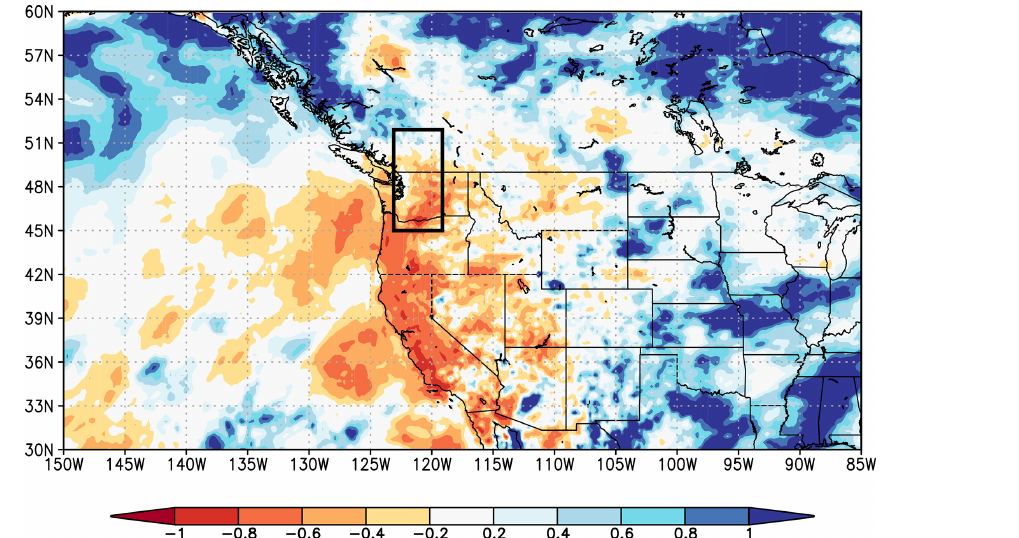
Figure 17. GPM/IMERG satellite estimates of relative precipitation anomalies in March–June 2021 relative to the whole record (2000– 2020). The value − 1 (dark red) denotes no precipitation, − 0 . 5 (orange) 50% less than normal and zero (light grey) normal precipitation. Origin: KNMI Climate